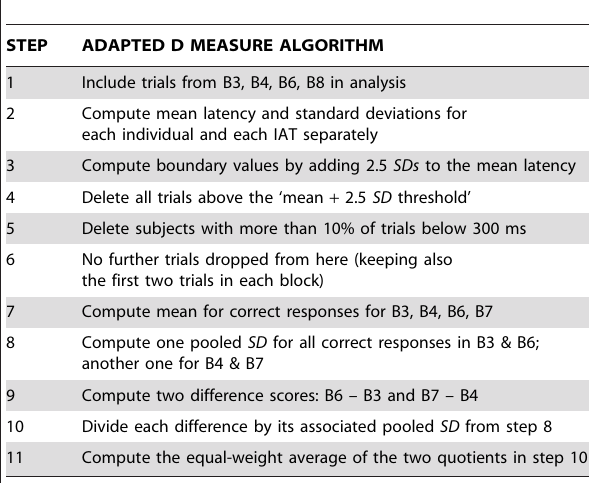
Table 2. Adapted D measure algorithm relying on the dynamic outlier criterion.